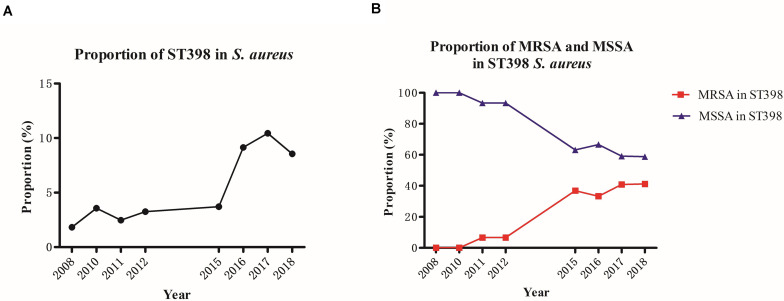
Prevalence of the total ST398 (A) and the increasingly emerging dominant MRSA ST398 clone (B) from different clinical specimens of patients, 2008–2018.